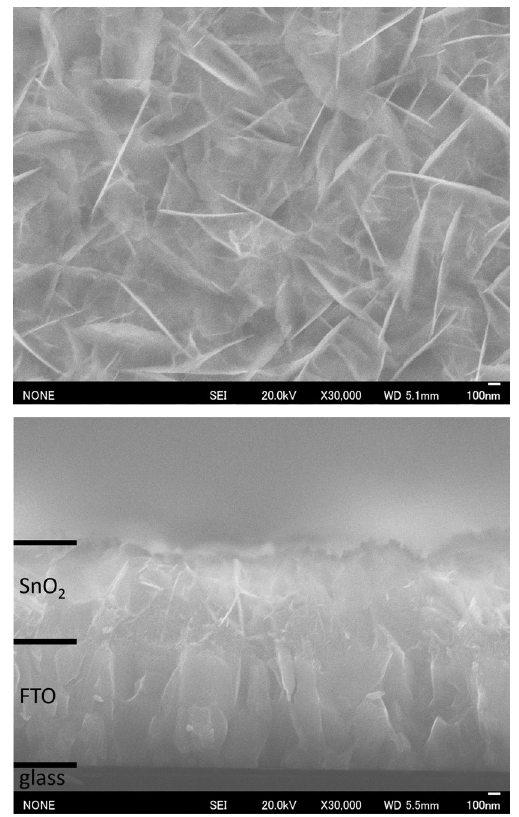
Figure 1. Surface (upper) and cross-sectional (lower) SEM images of the SnO 2 (101) nanosheet assembled